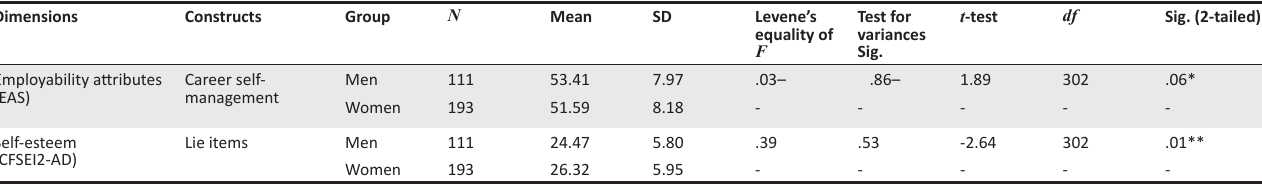
TABLE 7: Independent t -test – differences in gender scores on the measurement dimensions.